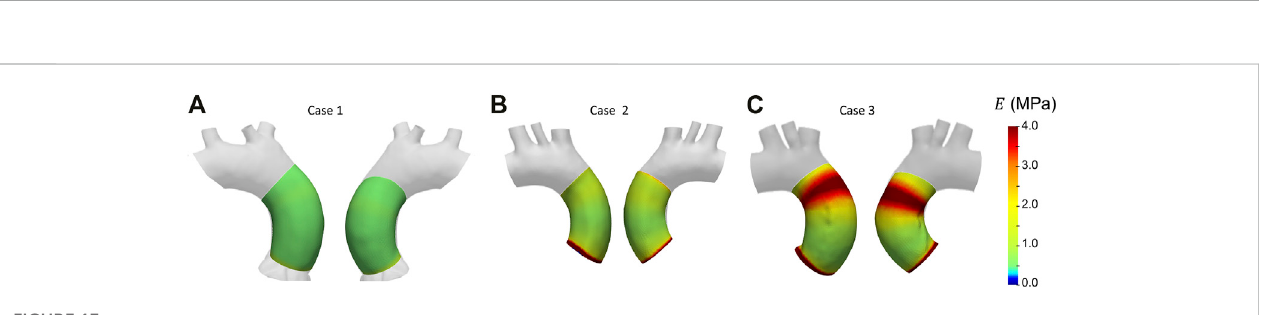
FIGURE 13 Young ’ s modulus maps from patient-speci fi c cases: Case 1 (A) , Case 2 (B) and Case 3 (C) .